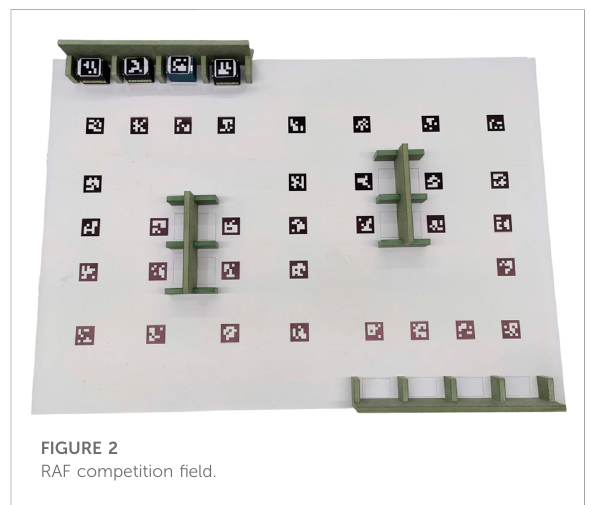
FIGURE 2 RAF competition fi